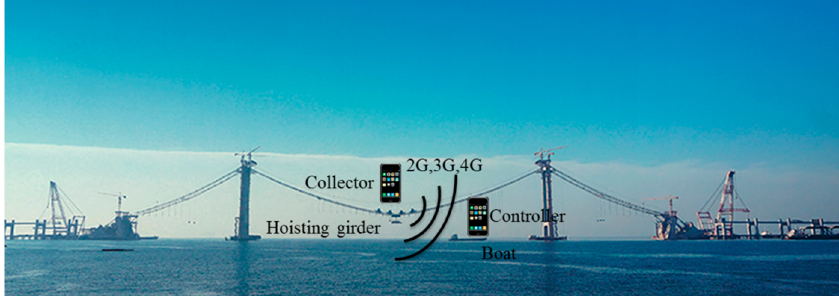
Figure 11. Schematic of the hoisting realization process.